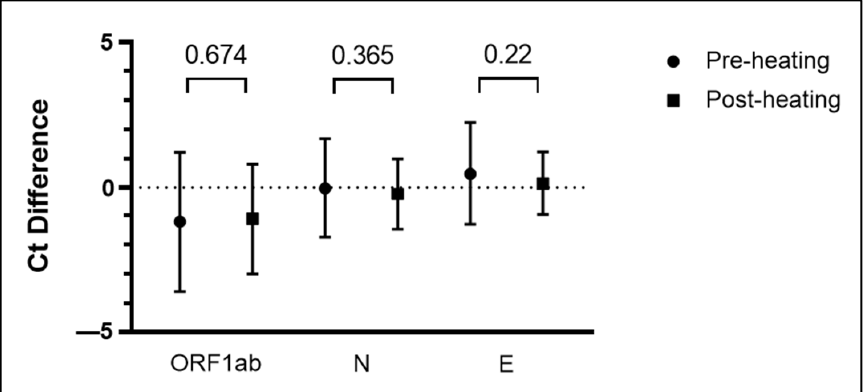
Figure 4. Validation of pre- or post-heating in pooling with positive control spike-in to negative saliva specimens, conducted on freshly collected saliva specimens. The paired t -test of Ct value difference between pre-and post-heating is indicated by the connecting line and p -value above it. Results were interpreted by mean ± SD from 18 pools of four with a range of 1–5 µ L for positive control.